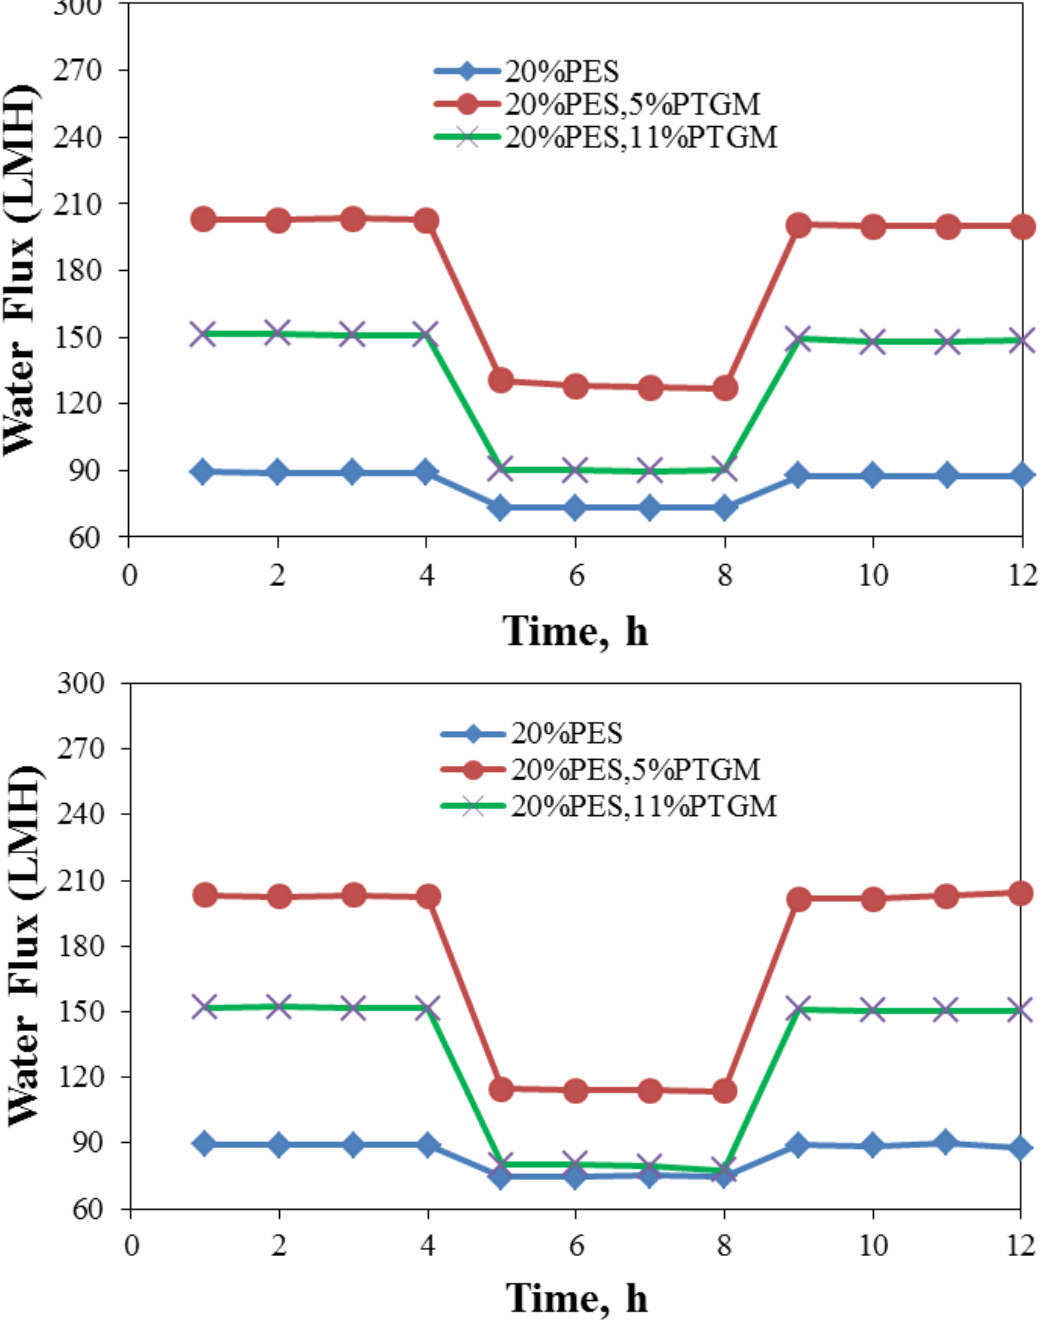
Figure 9. ( Top ) Flux vs. time for the PES/PTGM membranes at 0.4 MPa TMP during the following three steps: water flux for 4 h, 1000 ppm BSA flux for 4 h, and water flux for 4 h after 1 h washing with distilled water; ( Bottom ) Flux vs. time for the PES/PTGM blend membranes at 0.4 MPa TMP during the following three steps: water flux for 4 h, 50 ppm SA flux for 4 h, and water flux for 4 h after 1 h washing with distilled water.